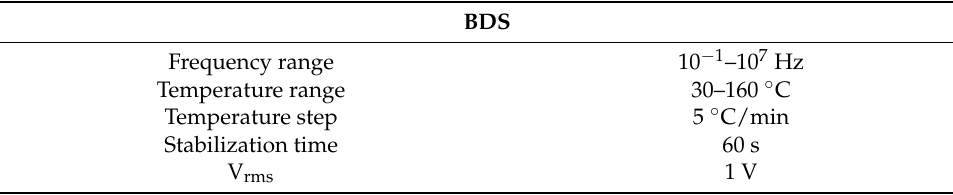
Table 4. BDS parameters.